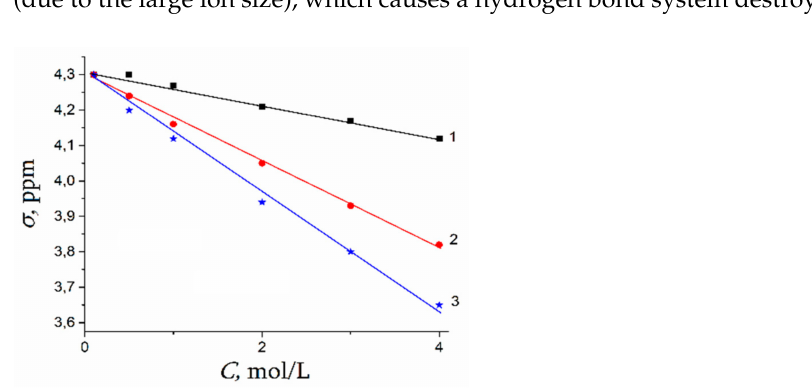
Figure 43. 1 H chemical shift dependences on concentration of LiCl (1), NaCl (2), CsCl (3) aqueous solutions